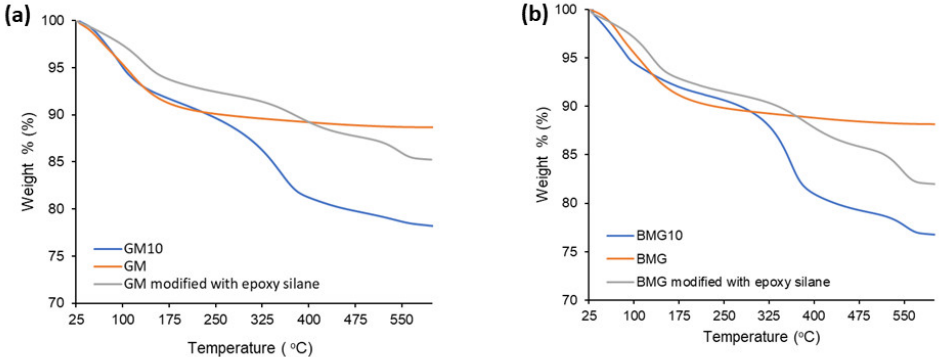
Figure 9. TG analysis of the ( a ) GM and ( b ) BGM samples.